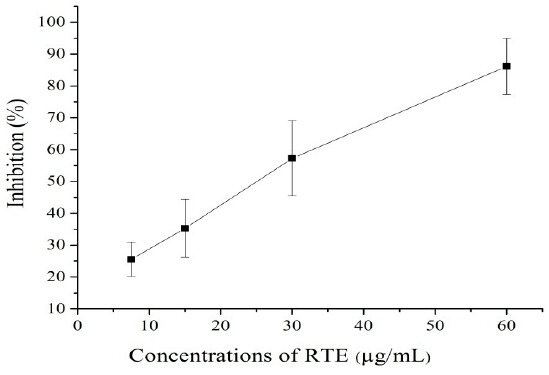
Figure 2. Radical scavenging activity of the Rosa rugosa tea extract (RTE); means ± SD of triplicate analyses.